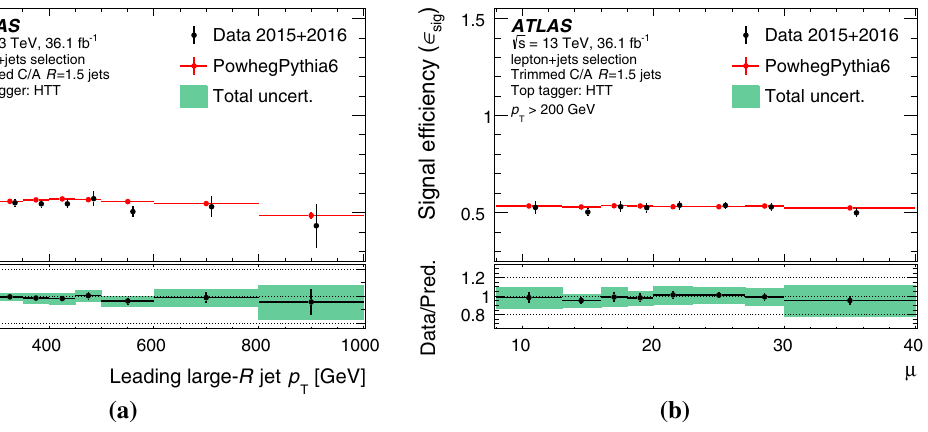
Fig. 23 The signal efficiency on contained top-quark jets for the HEP- TopTagger top-quark tagger as a function of the large- R jet p T ( a ) and the average number of interactions per bunch crossing μ ( b ) in data and simulation. Statistical uncertainties of the signal efficiency measure- ment in data and simulation are shown as error bars in the top panel. In the bottom panel, the ratio of the measured signal efficiency in data to that estimated in Monte Carlo is shown with statistical uncertainties